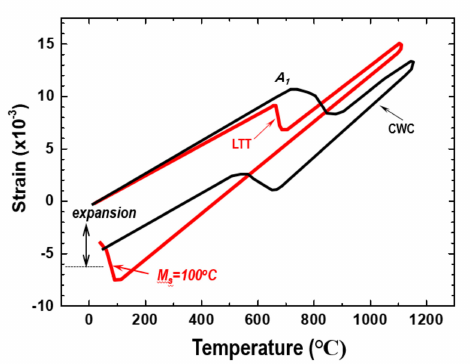
Figure 11. Thermal dilation experiments using specimens extracted from the low transformation temperature and commercial welding